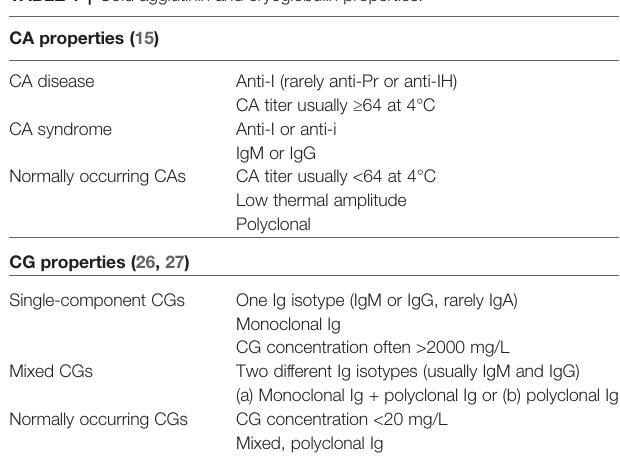
TABLE 1 | Cold agglutinin and cryoglobulin